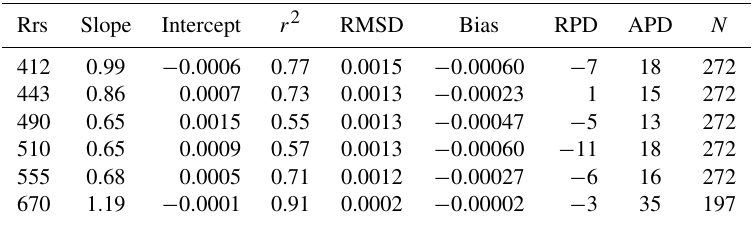
Table 3. Statistics associated with the Multi-Rrs product (sr − 1 ) computed over the MedBiOp dataset. The same statistics associated with all products shown in Fig. 7 are provided in the Supplement (Tables S2 to